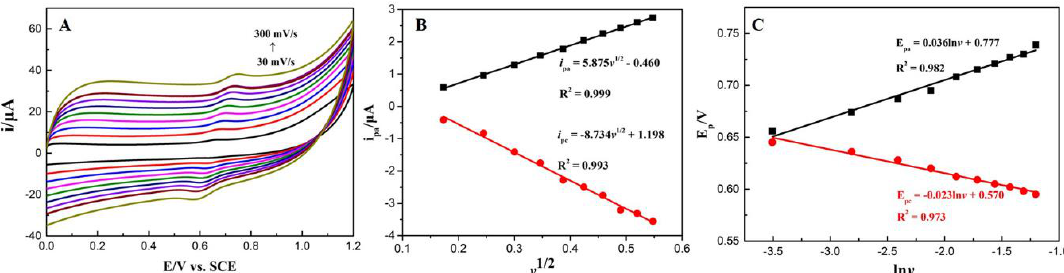
Figure 7. ( A ) Cyclic voltammograms of 10 μM of Allura Red at various scan rates. ( B ) Linear plots of anodic and cathodic peak currents of Allura Red against the square root of scan rates ( v 1 / 2 ); ( C ) Linear plots of anodic and cathodic peak potentials against the Napierian logarithm of scan rates (ln v ).